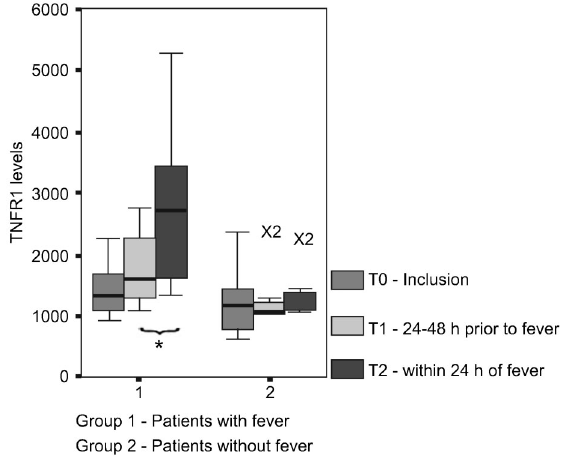
Figure 1. Plasma levels of soluble TNF- a I receptor (TNFRI) measured at enrollment, 24 to 48 h before the occurrence of fever, andwithin24 hof feveronset (group1)comparedtothecorrespond- ingdaysinthegroupwithoutfever(group2).X2=outliers.*P , 0.05 compared to group 2 (Mann-Whitney